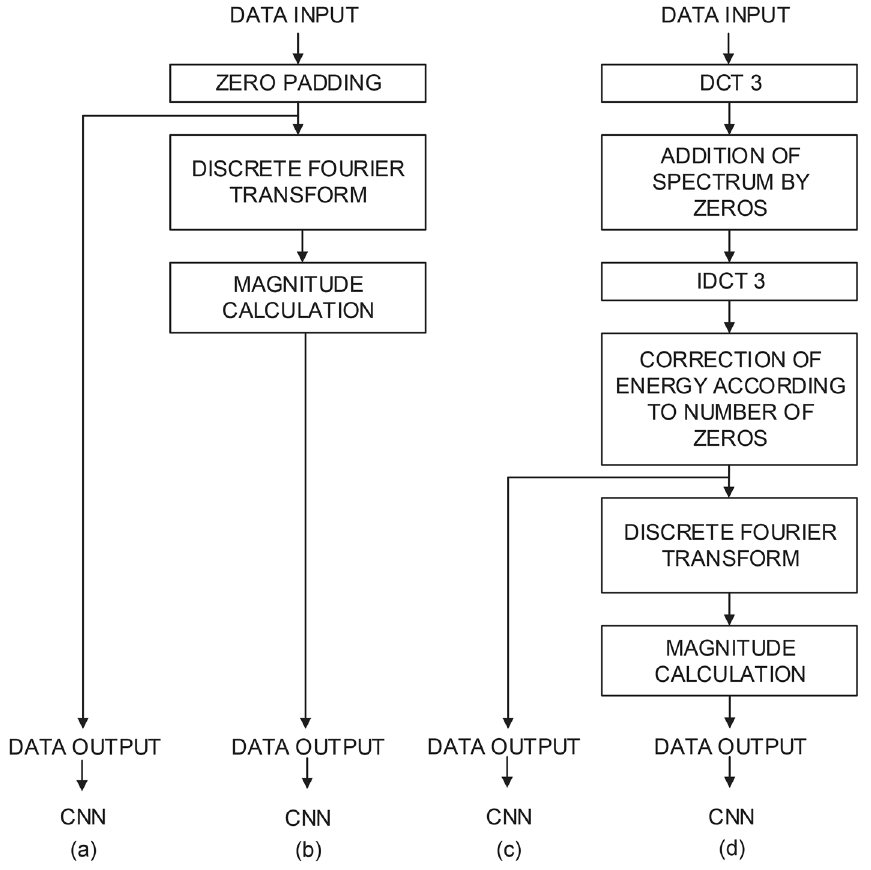
Figure 3. A block scheme of the designed and tested data processing methods; ( a ) time domain zero padded signal, ( b ) spectrum of time domain zero padded signal, ( c ) time domain interpolated signal, ( d ) spectrum of time domain interpolated